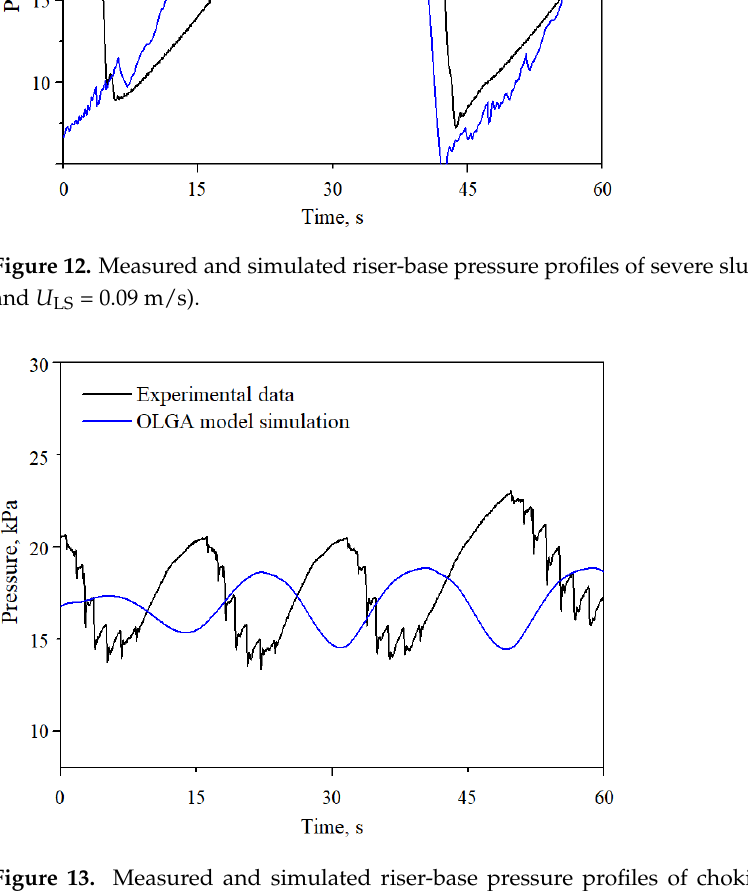
Figure 12. Measured and simulated riser-base pressure profiles of severe slugging ( U GS = 0.08 m/s and U LS = 0.09 m/s).